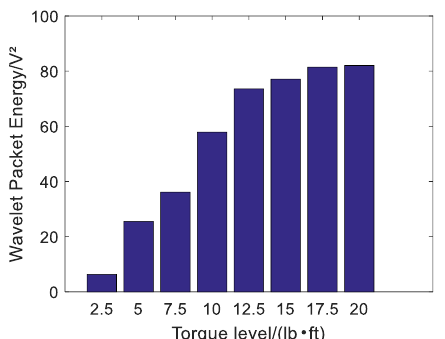
Figure 9. Wavelet packet energy of bar 5 under different torque levels.